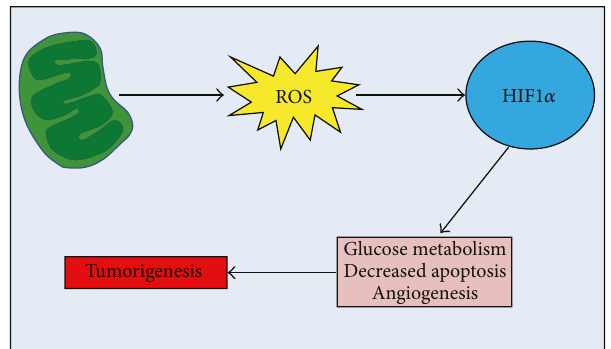
Figure 2: Mitochondrial dysfunction and hypoxia in cancer. Schematic representation of the role of mitochondrial dysfunction in tumorigenesis. Damaged mitochondria release ROS which on turn activates HIF1 𝛼 . Finally, HIF1 𝛼 activates the tumorigenic hypoxia pathway by initiating transcription of genes involved in glucose metabolism, angiogenesis, and